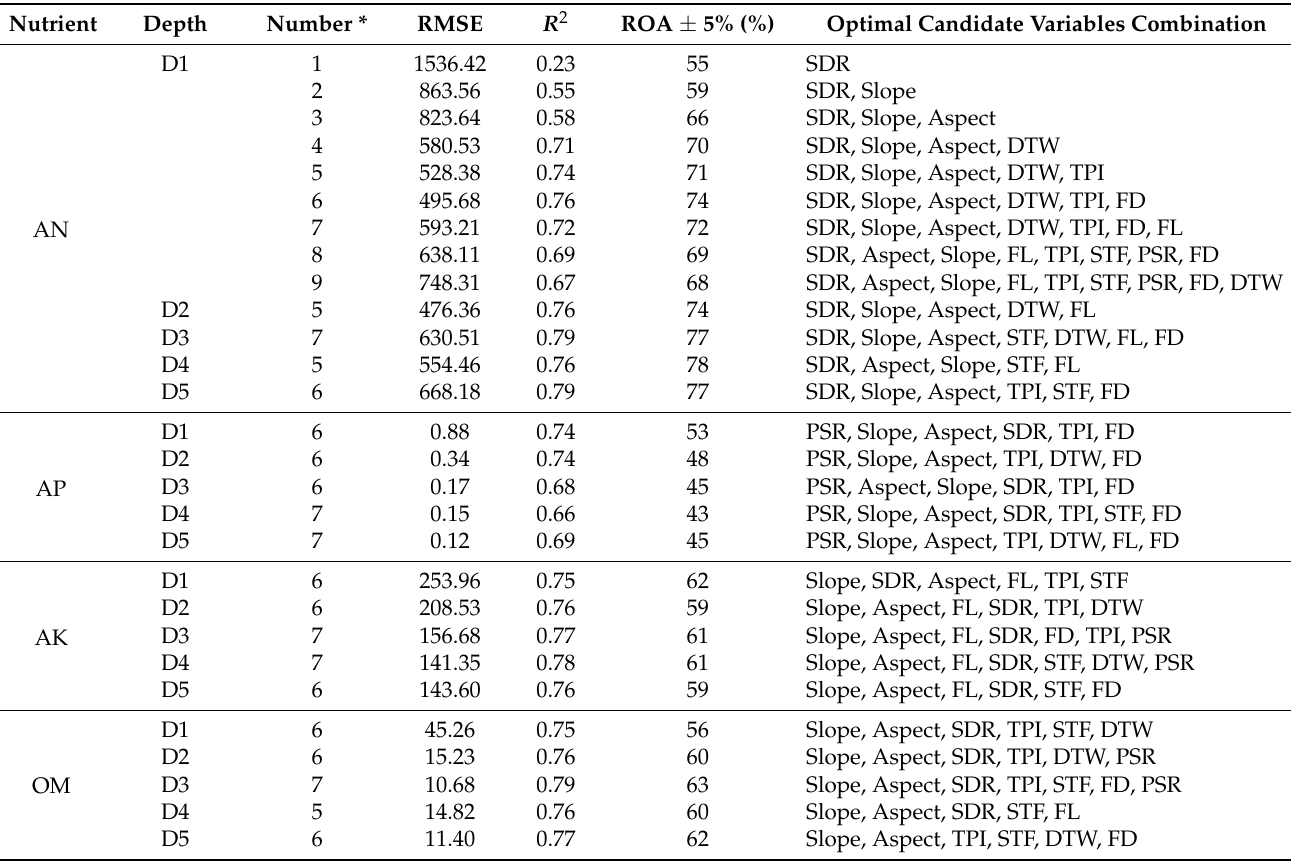
Table 2. Optimal variable combination and accuracies of the terrain hydrology ANN model (Model A) of soil nutrients. Nutrient